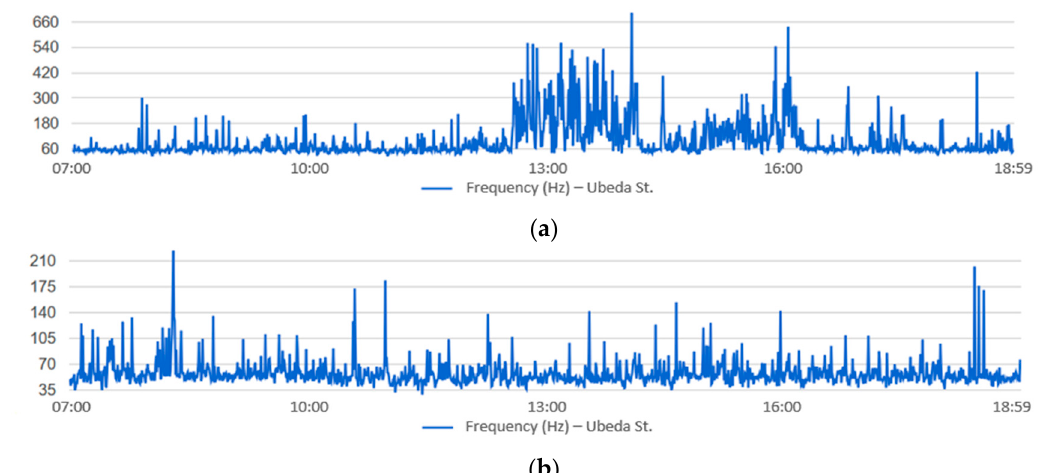
Figure A8. ( a ) The predominant frequency measured by the sensor node located in Ubeda Street on a weekend day, 13 November 2016, with the presence of people; ( b ) the predominant frequency measured by the sensor node on a weekday, 9 November 2016, without the presence of